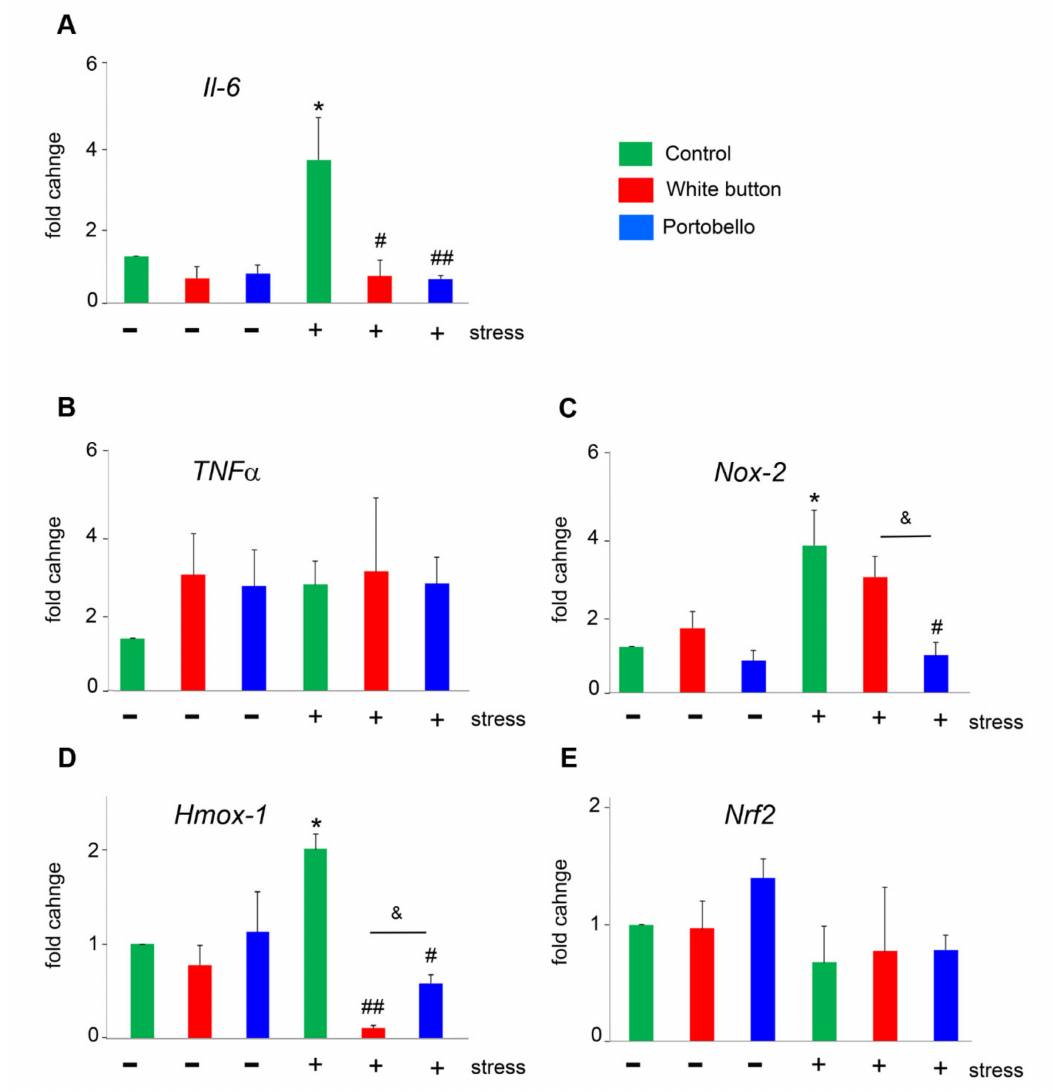
Figure 4. Expression of genes related to oxidative stress, including Il-6 ( A ), Tnf α ( B ), Nox-2 ( C ), Hmox-1 ( D ), and Nrf2 ( E ). Bars represent the mean and standard error of the mean (SEM) of all measurements ( n = 5). *: p < 0.05 versus control. #: p < 0.05 and ##: p < 0.01 versus the stressed control. &: p < 0.05 between